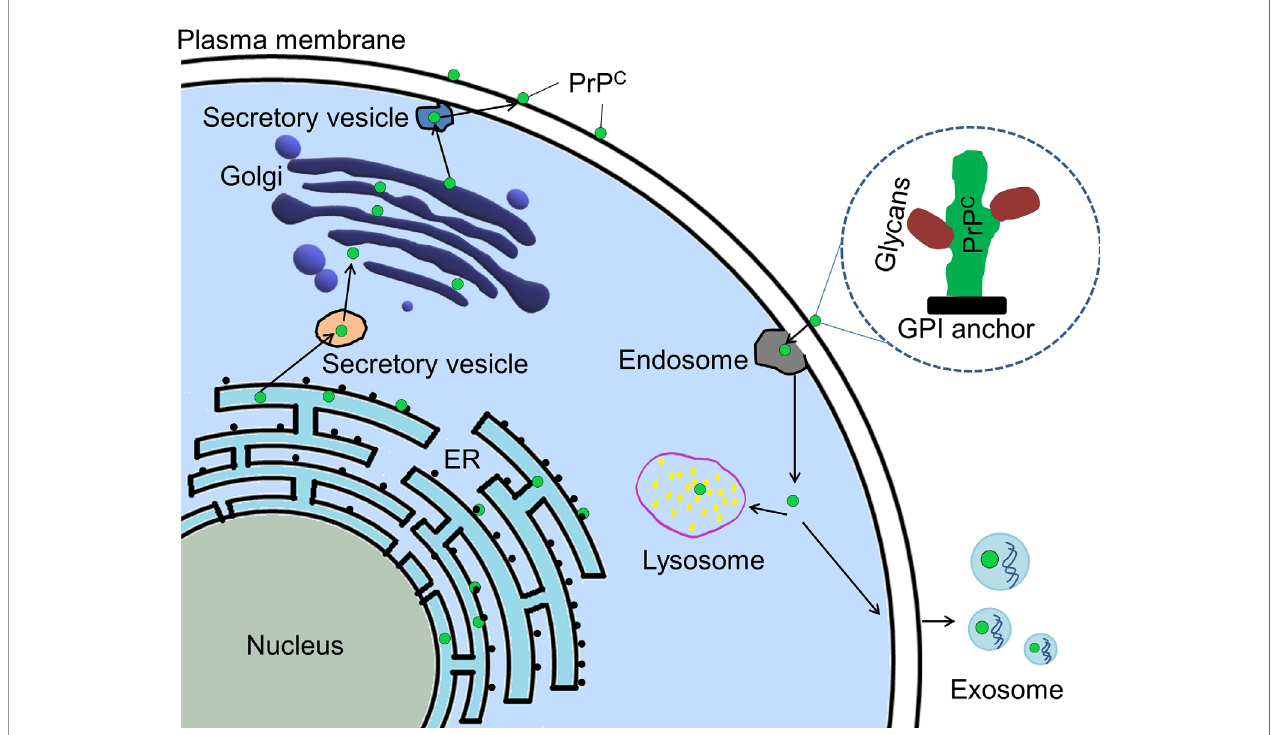
FIGURE 1 | Cellular traf fi cking pathway of PrP C . PrP C (green dot) is synthesized in ribosome attached to ER (endoplasmic reticulum). PrP C is imported to ER where it will be glycosylated and modi fi ed by GPI anchor before it is transported into Golgi apparatus for further modi fi cation. Mature PrP C is traf fi cked to plasma membrane and located there by its GPI anchor. Some mature PrP C could be endocytosed for degradation in the lysosome or for being contained in exosomes and secreted outside the cell. PrP C , Cellular prion protein; GPI,